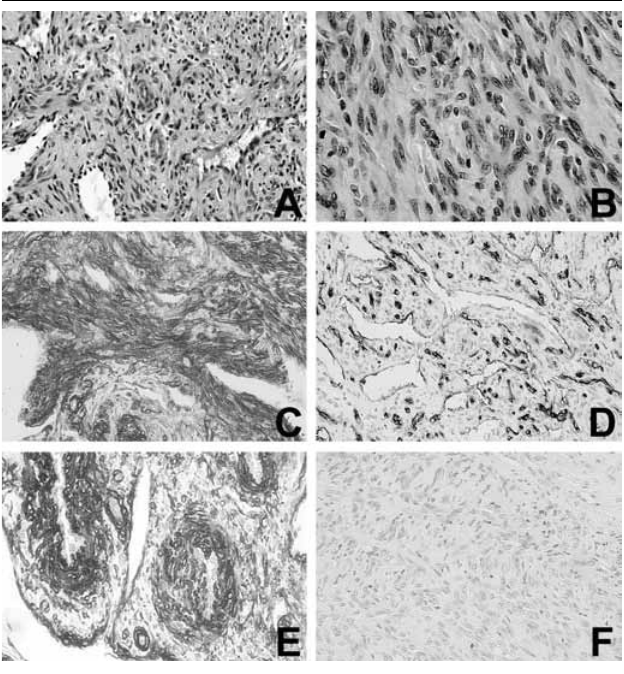
figurE 3 – Microscopic features of the angioleiomyoma A: smooth muscle proliferation around slit-like endothelium-lined vascular spaces (hematoxylin-eosin; original magnification 100×); B: large tumor cells with indistinct cell margins and faintly eosinophilic cytoplasm, showing elongated nuclei with rounded edges (hematoxylin-eosin; original magnification 200×); C: immunostaining for smooth- muscle actin showing strong positivity in the proliferating spindle-shaped cells, which form thick vessel walls (streptavidin-biotin technique; original magnification 100×); D: CD34 immunoreactivity is observed in the endothelial cells, demonstrating the high grade of vascularization of the lesion (streptavidin-biotin technique; original magnification 100×); E: neoplastic cells with positive immunostaining for desmin (streptavidin-biotin technique; original magnification 100×); F: neoplastic cells negative for S-100 (streptavidin-biotin technique; original magnification